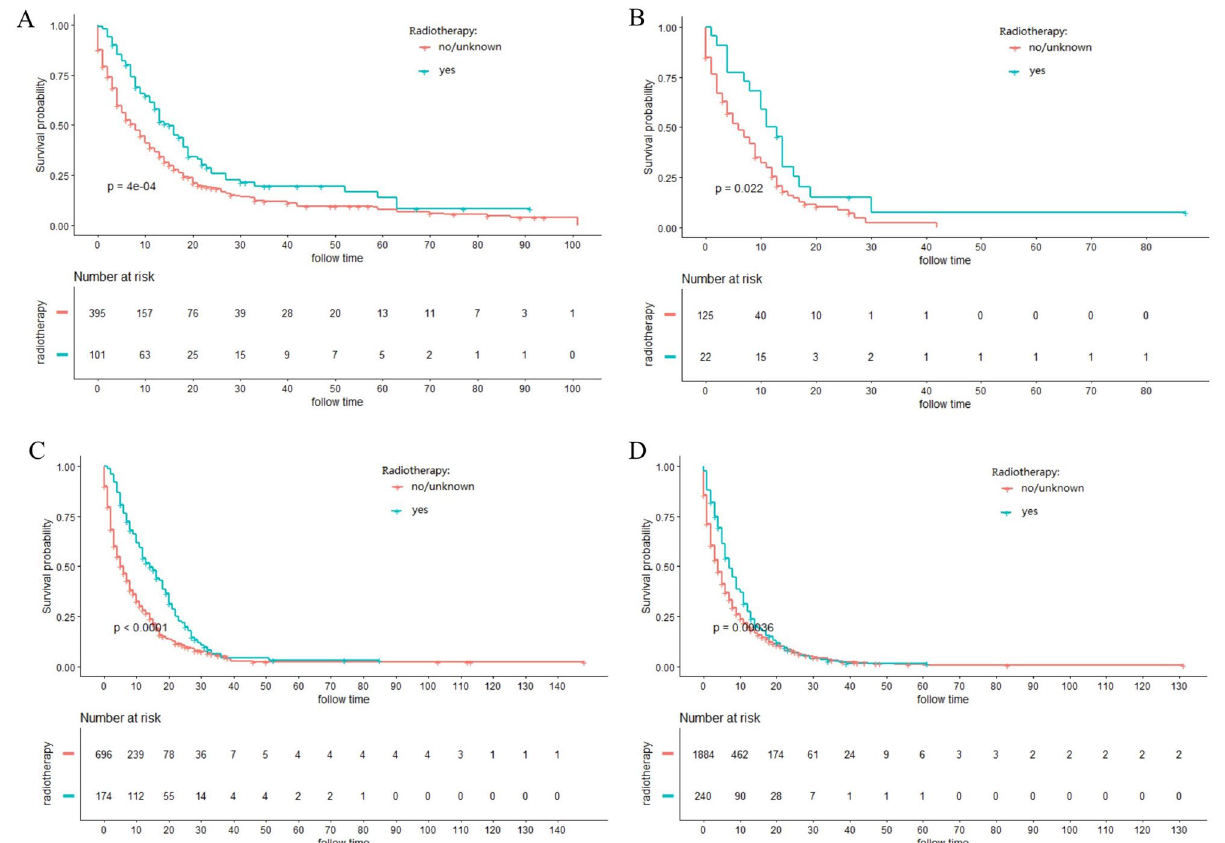
Figure 4. Kaplan–Meier curves for cancer-specific survival (CSS) in different AJCC stage between radiotherapy and no-radiotherapy groups in unresectable ICC patients: ( A ) stage I; ( B ) stage II; ( C ) stage III; ( D ) stage